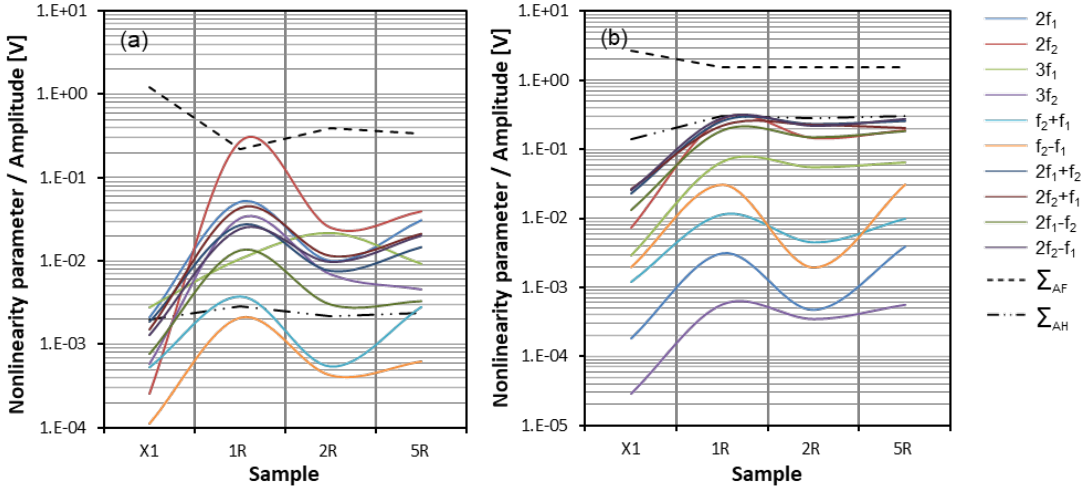
Figure 19. Nonlinearity parameter: ( a ) f 1 = 3 MHz, f 2 = 5 MHz, α = 45°; ( b ) f 1 = 4 MHz, f 2 = 5 MHz, α = 45°.